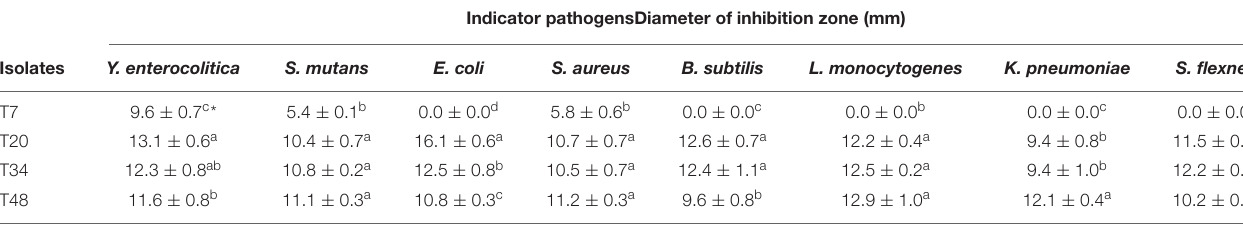
TABLE 4 | The inhibitory effect of isolated LAB strains against pathogens. Values shown are means ± standard deviations ( n = 3). Indicator pathogensDiameter of inhibition zone